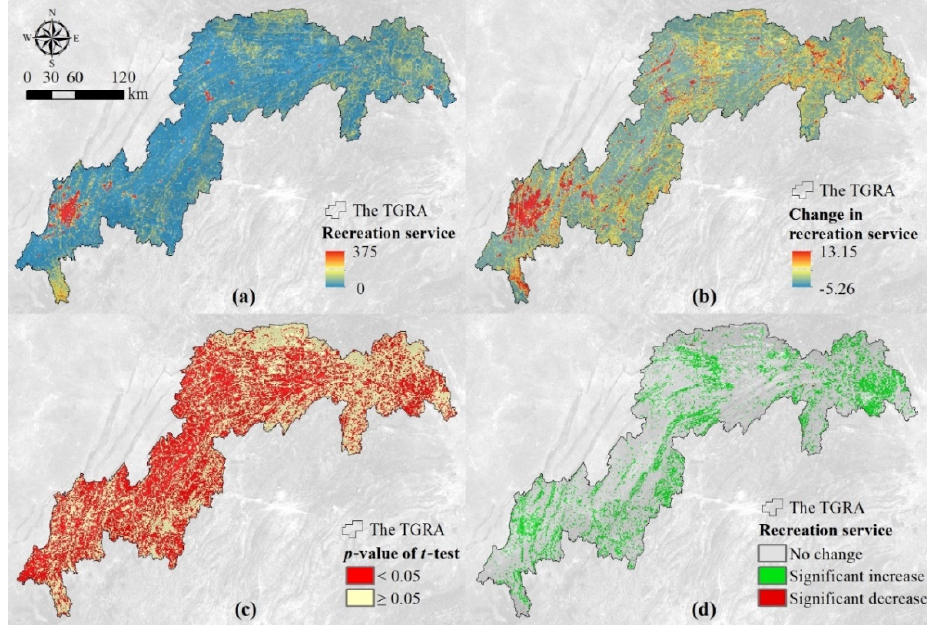
Figure 2. Spatial variation of the recreation-service proxy in the TGRA between 2000 and 2015. Average ( a ) and the modeled slope ( b ) of the recreation service, p -value of t -test for the slope ( c ), and the changes of recreation service ( d ). Note: In the figure ( d ), “No change” shows that the recreation service did not significantly change (slope = 0), and “Significant increase” refers to slope > 0 and p < 0.05, while significant decrease refers to slope < 0 and p < 0.05.